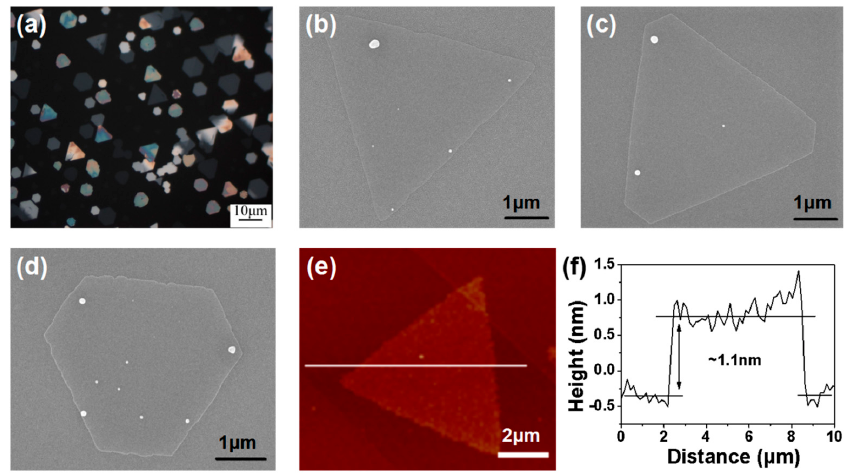
Figure 1. Morphology of as-synthesized atomic-layer SnSe 2 nanoflakes. ( a ) Large-scale optical microscopy (OM) image of as-grown SnSe 2 nanoflakes on mica to show high yield of SnSe 2 ; Typical scanning electron microscopy (SEM) images of SnSe 2 single crystal with ( b ) triangle; ( c ) truncated triangle, and ( d ) hexagon, respectively; ( e ) Atomic force microscopy (AFM) image of a typical SnSe 2 nanoflake; ( f ) The height profile in ( e ) indicates that the SnSe 2 nanoflakes are monolayer. The chemical compositions and bonding types of the SnSe 2 nanoflakes grown on mica by CVD method were examined with XPS. It provides the information on stoichiometry and bonding of samples. Eight elements are present in the spectra shown in Figure 3a. Sn and Se elements come from the SnSe 2 nanoflakes, and others come from the mica (KMg 3 (AlSi 3 O 10 )F 2 ) substrate. The 3d spectra of the SnSe 2 samples (Figure 3b,c) have Sn3d 3/2 , Sn3d 5/2 , Se3d 3/2 , and Se3d 5/2 peaks which can be observed at 495.0 eV, 486.5 eV, 55.8 eV and 53.5 eV, respectively [40]. Sn3d 3/2 and Sn3d 5/2 characteristic peaks are situated at 495.0 and 486.5 eV, respectively, certifying that tin is in its Sn (IV) state [41,42]. The binding energies of 55.8 and 53.5 eV are attributed to the doublet Se3d 3/2 and Se3d 5/2 peaks corresponding to the − 2 state of Selenium, which coincides with the values of the previous work [43]. The characteristic peaks of tin indicate that the valence state of Sn changes from Sn 2+ to Sn 4+ [42]. The peaks of Se at about 55 eV were split into Se3d 5/2 (53.5 eV) and Se3d 3/2 (55.8 eV) [43]. The XPS further suggests that the products are SnSe 2 without other impurities, such as SnSe.